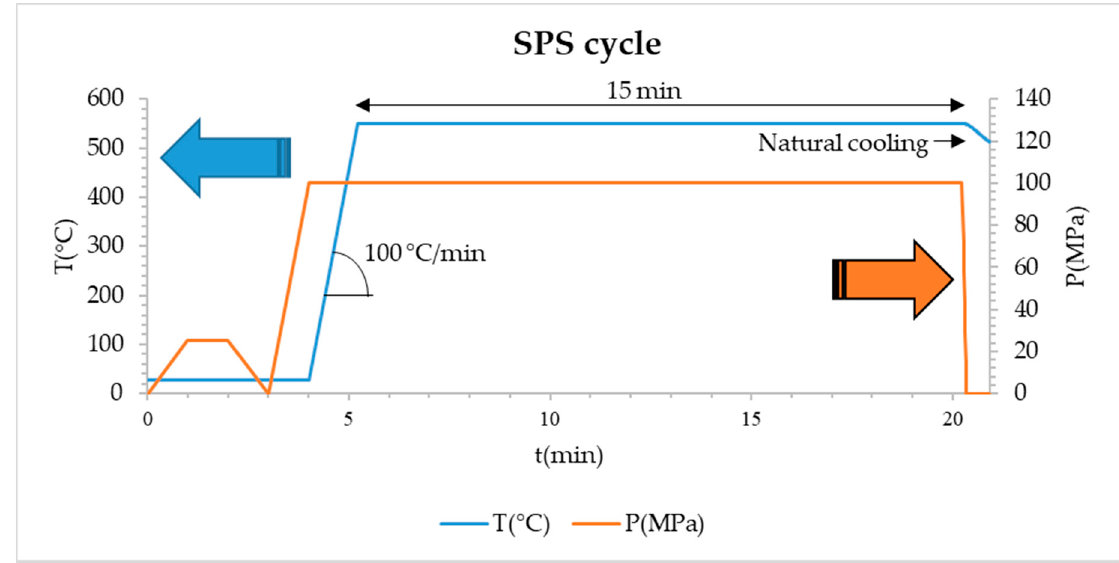
Figure 1. SPS cycle. The blue line represents the temperature cycle, while the orange line represents the pressure cycle.